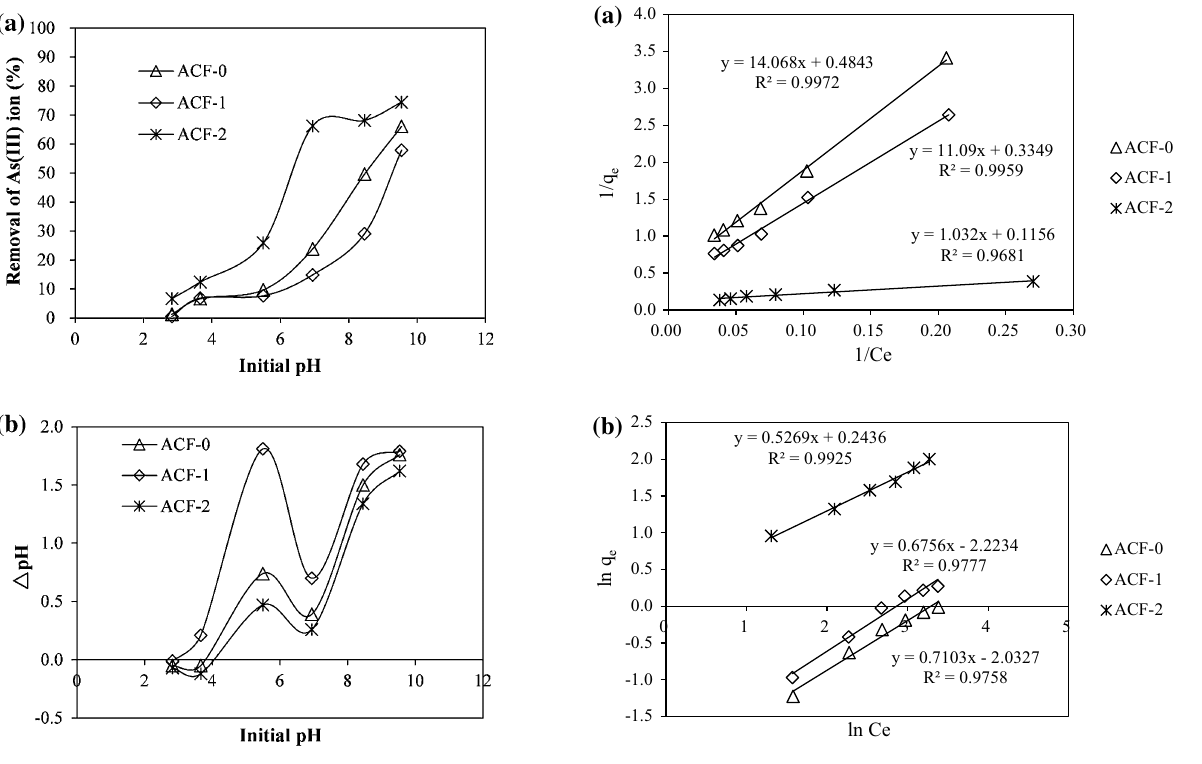
Fig. 5 Effect of the initial pH on the adsorption of As (III) by ACF-0, ACF-1 and ACF-2. Dosages of absorbents were 500 mg/L; concen- tration of As (III) was 2 mg/L; and reaction time was 300 min